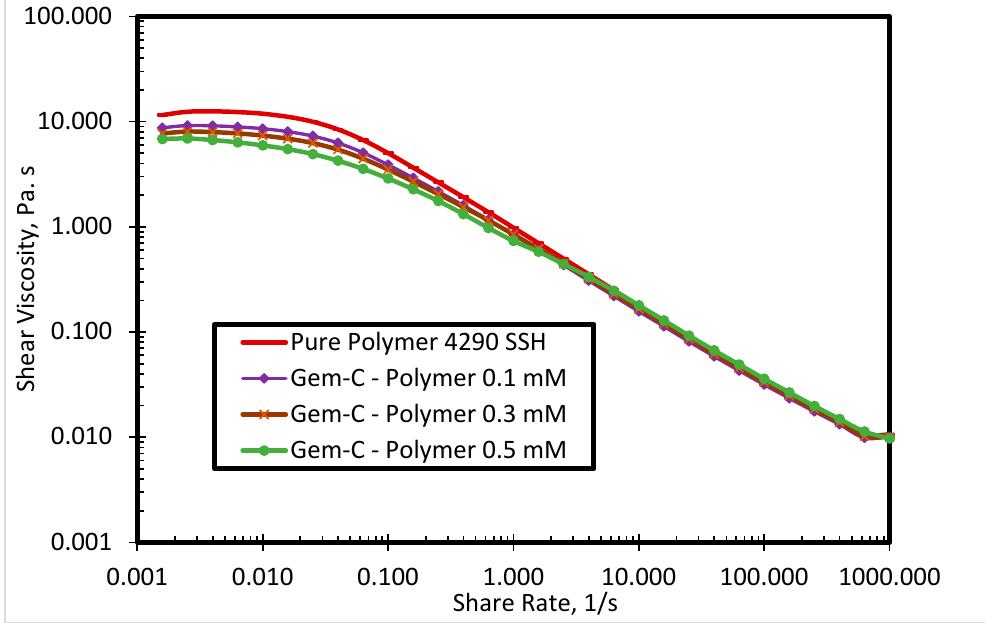
Figure 5. Shear viscosity of 4290 SSH polymer with Gem-A surfactant at different concentrations.